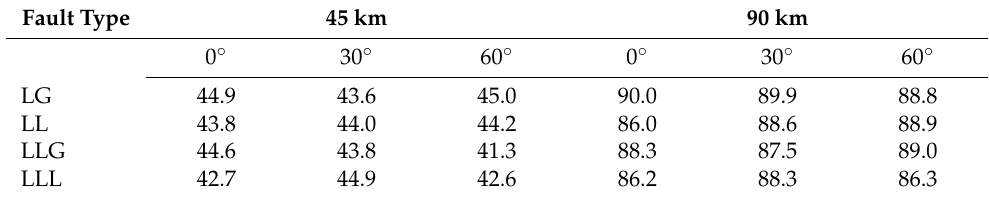
Table 19. Fault estimation at 45 and 90 km with a 10 Ω fault impedance with PV and WE sources.